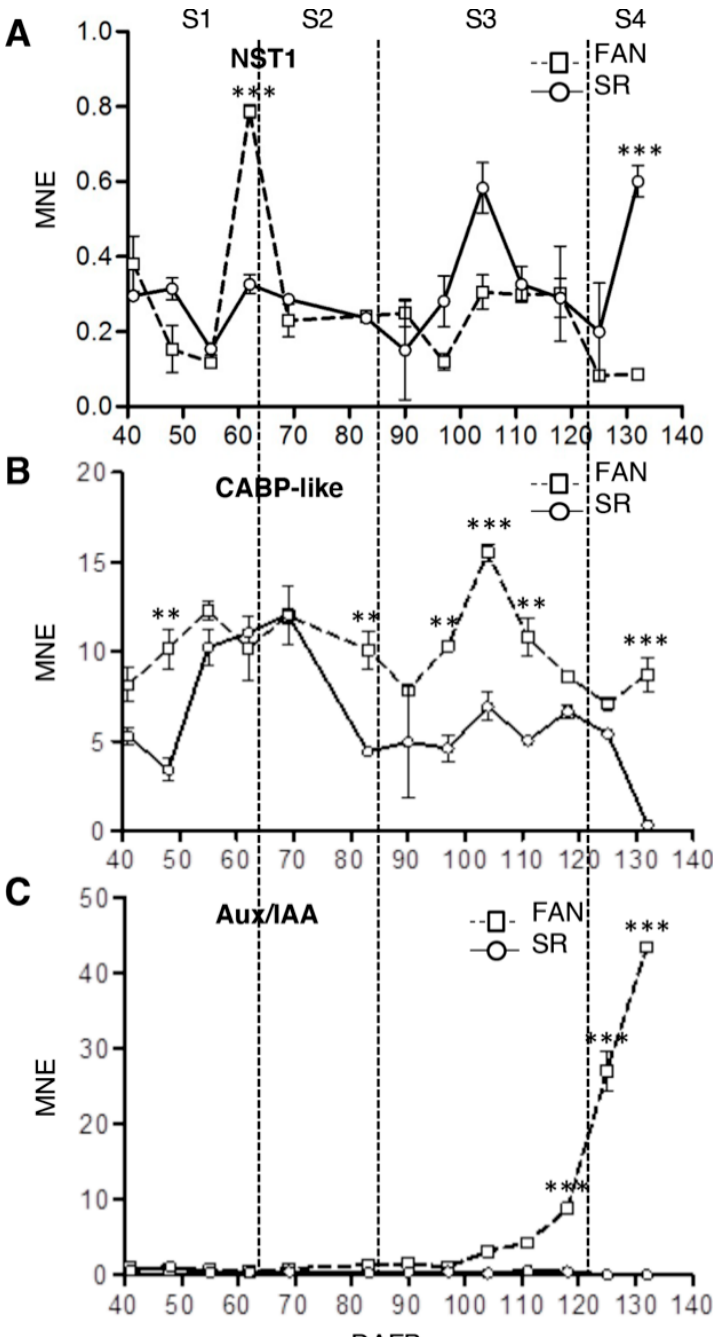
Figure 3. Expression analysis of selected target genes controlling fruit identity tissue and marking fruit development phases during the growth period of FANTASIA (FAN) and low ripening (SR) genotype fruits. Real-time qPCR expression analysis of peach ortholog of NST1(Prupe.5G131900, Panel A ), CABP-like (Prupe.5G117500, Panel B ), and Aux/IAA (Prupe.8G232200, Panel C ) genes throughout fruit development in the mesocarp of cv. FAN (square, dashed line) and SR (circle, continuous line) (for details and primer sequences see Methods). Developmental stages (S1, S2, S3, and S4) are indicated at the top of each chart, taking FAN as a reference. Highly and extremely significant differences as determined by Student’s t test are indicated with two ( p ≤ 0.01) and three ( p ≤ 0.001) asterisks, respectively. MNE: Mean normalized expression, DAFB: Days after full bloom. Bars represent standard deviation ( n =